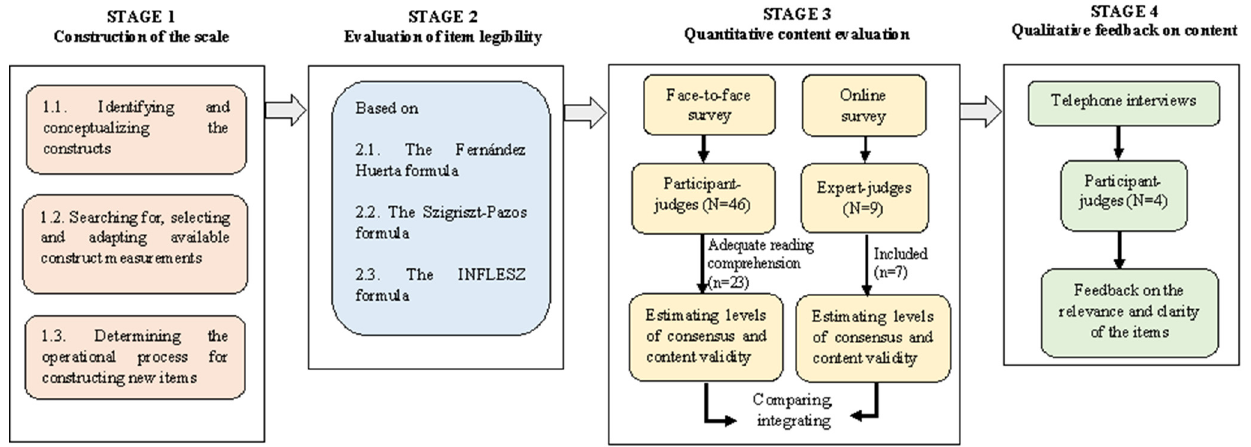
Figure 1. General diagram of the study: processes for the development and evaluation of the scale.